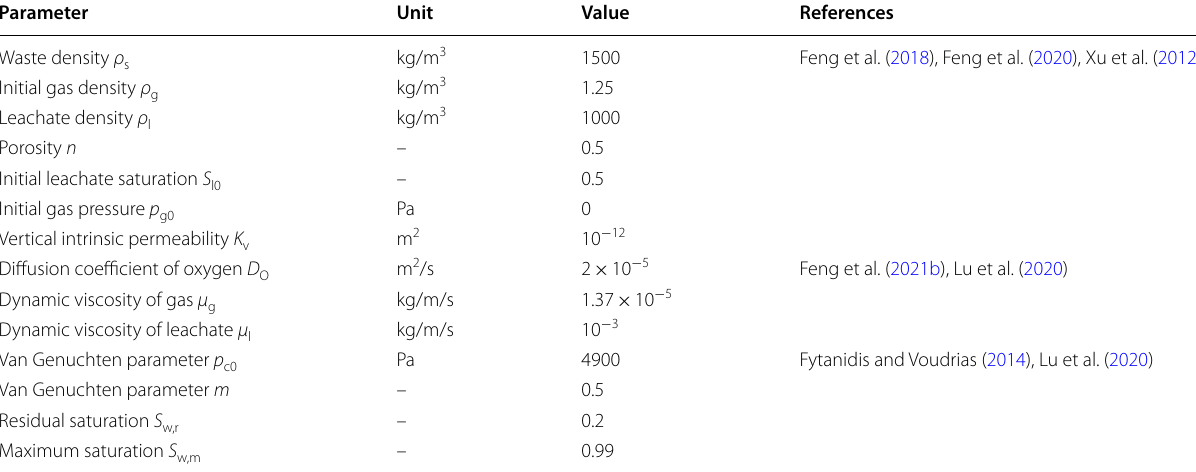
Table 3 Hydraulic parameters used in this